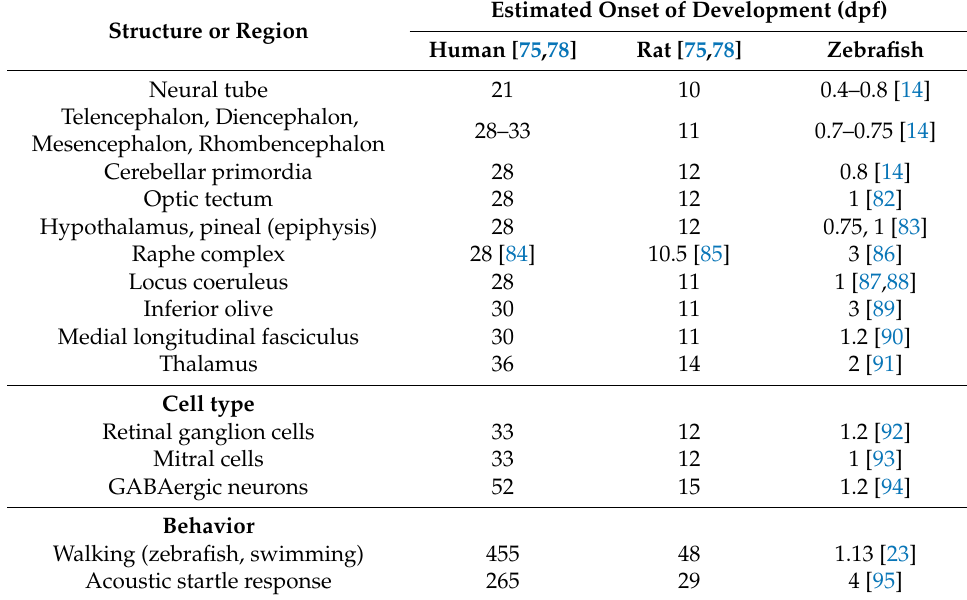
Table 1. A timeline of neurogenic events in mammals and zebrafish. Time periods represent approximate dates related to morphological delineation, onset of neurogenesis and onset of behavior. Time periods are approximated as days post-fertilization